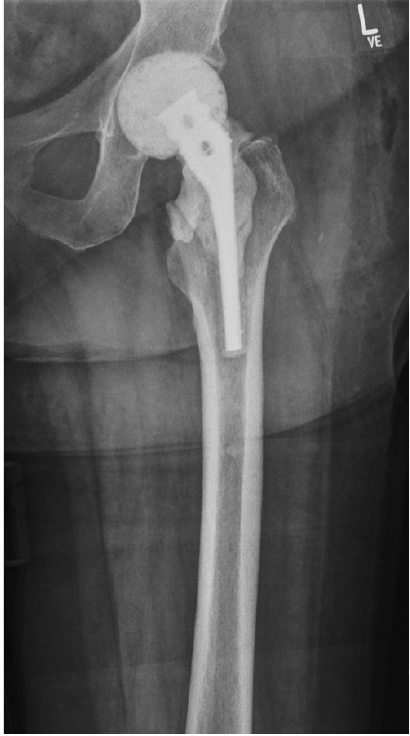
Figure 2: Anteroposterior X-ray of the left hip joint showing an antibiotic-loaded cement hip spacer with a titanium endoskeleton acting as a